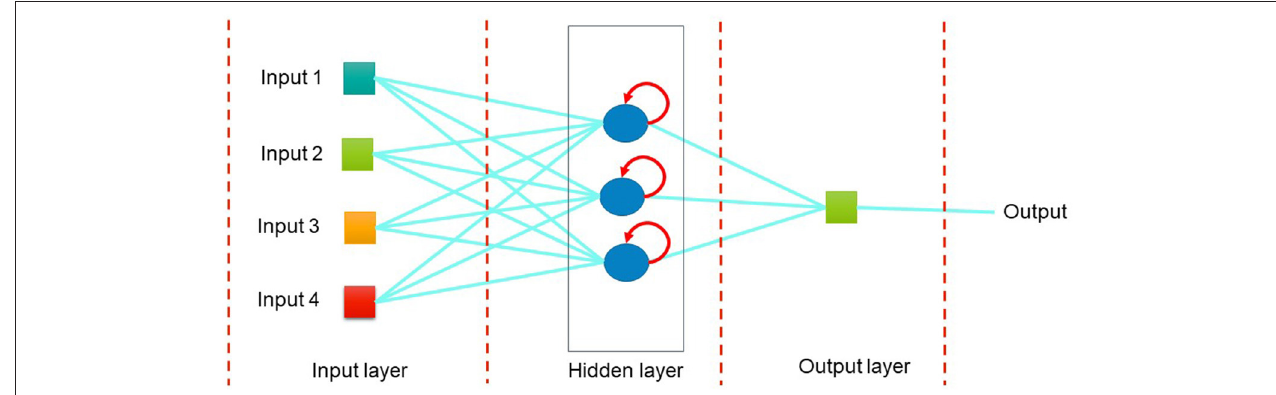
FIGURE 6 | Schematic diagram of RNN